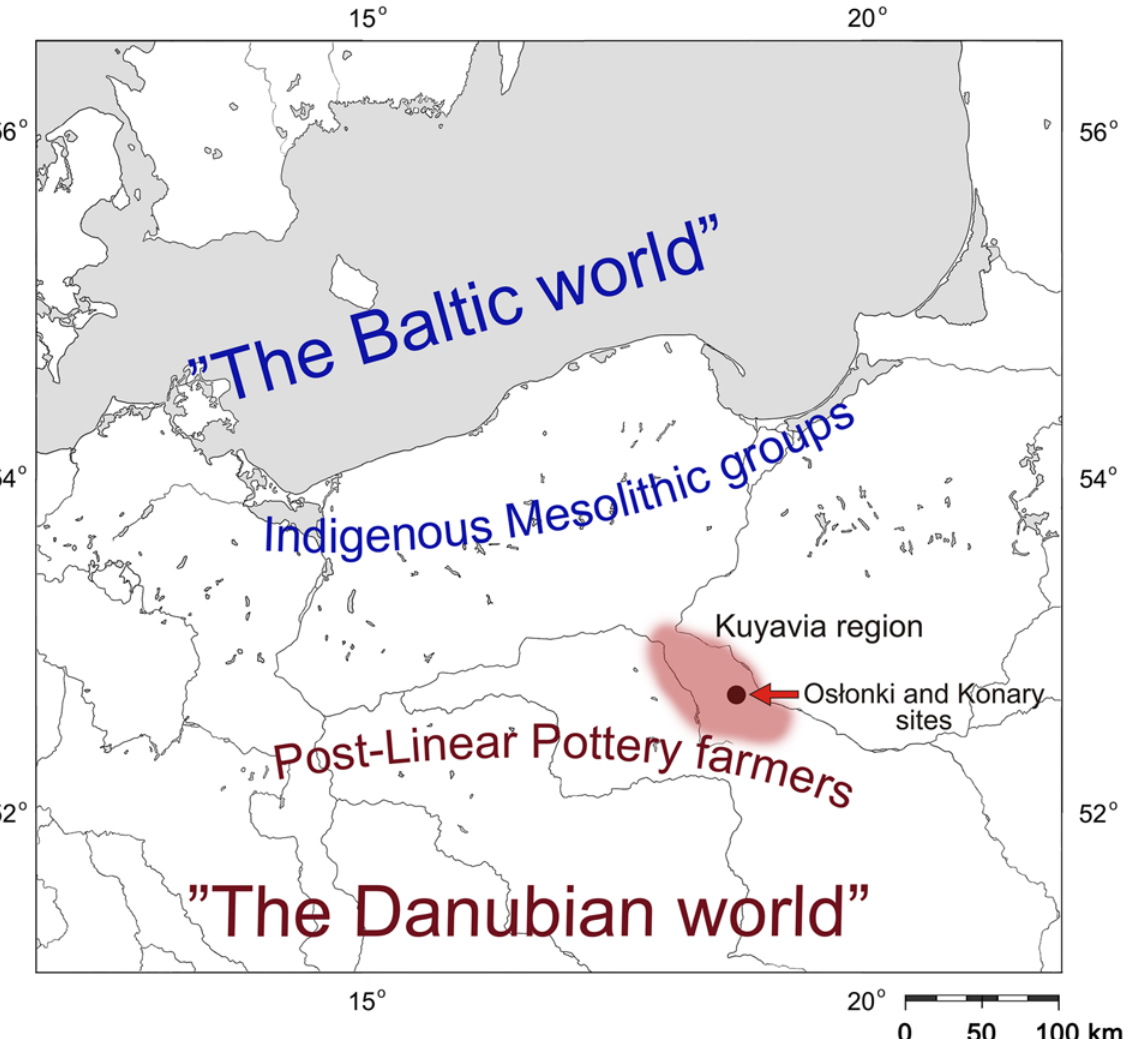
Fig 2. Map showing the location of the Kuyavia region and discussed sites in the north-central Poland. The names of cultural units outline the approximate edges of the territories populated by indigenous foragers populations and Neolithic farmers during the fifth millennium BC (after: